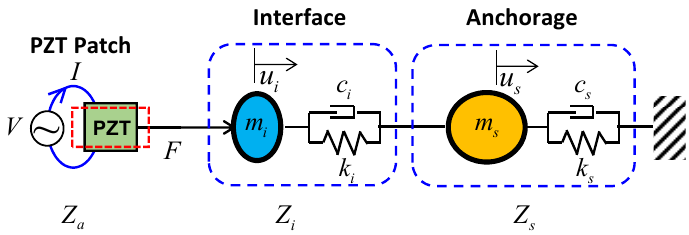
Figure 2. Analytical impedance model of a PZT interface-anchorage interactive system.